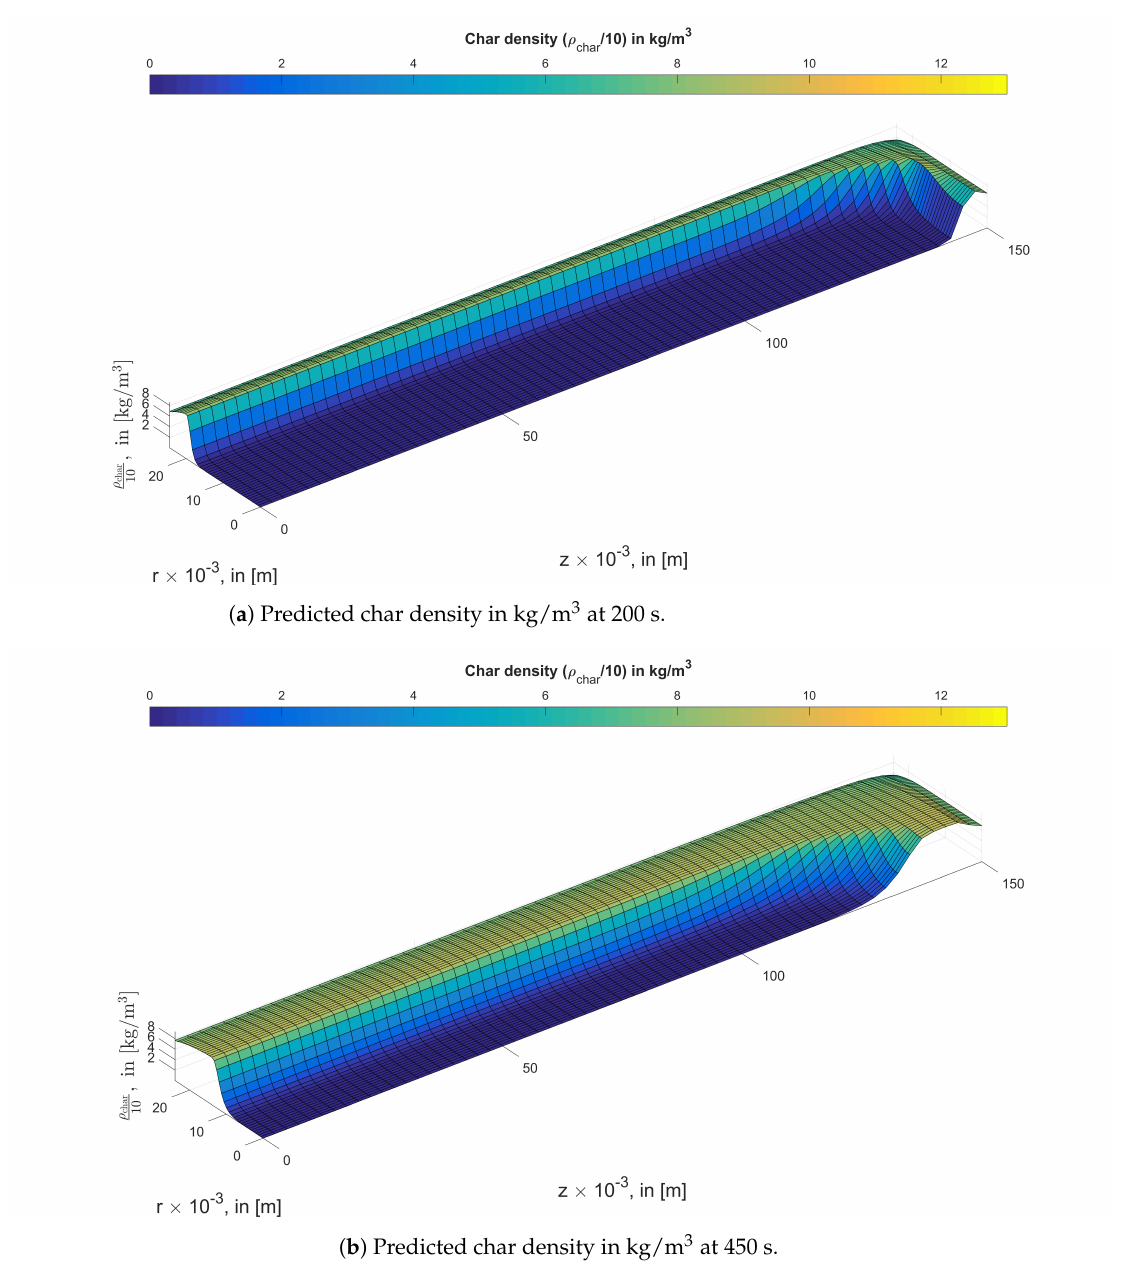
Figure 5. Char densities in kg/m 3 at 200 s and 450 s during devolatilization. The top of the wood log is marked at z = 150 mm, and the lateral shell surface of the wood log is at r = 25